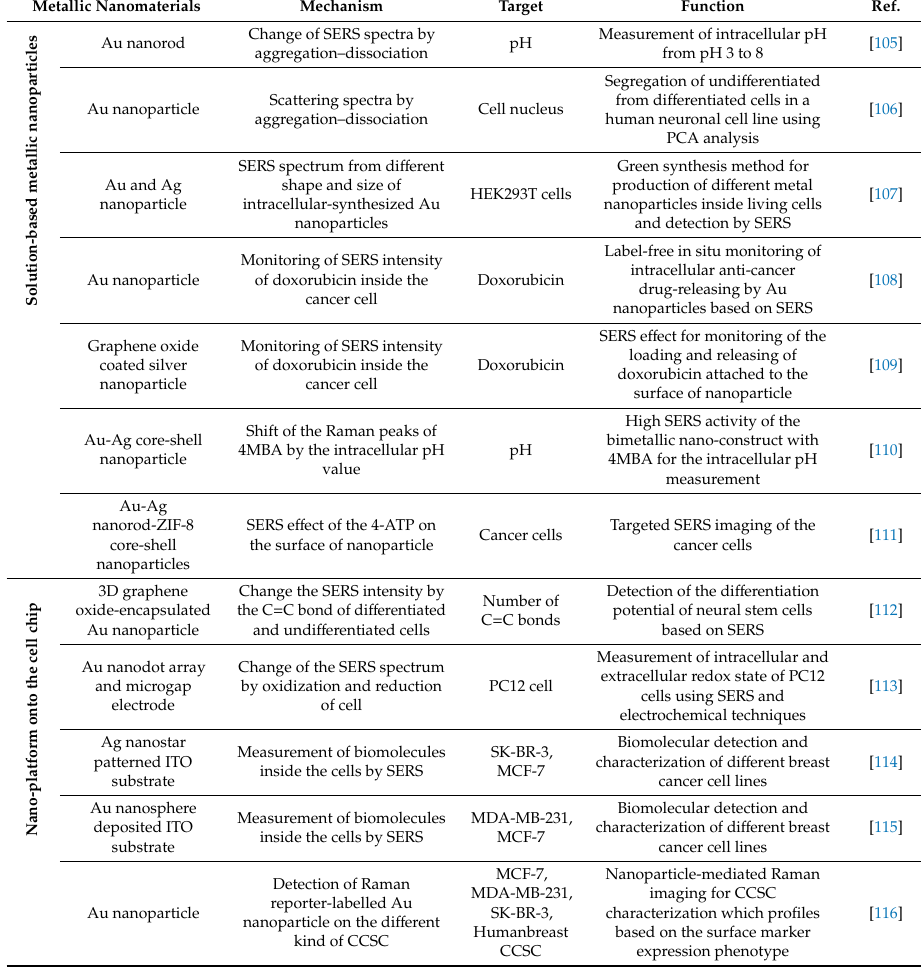
Table 3. Surface-enhanced Raman spectroscopy (SERS)-based analytical platforms for the cell analysis with the metallic